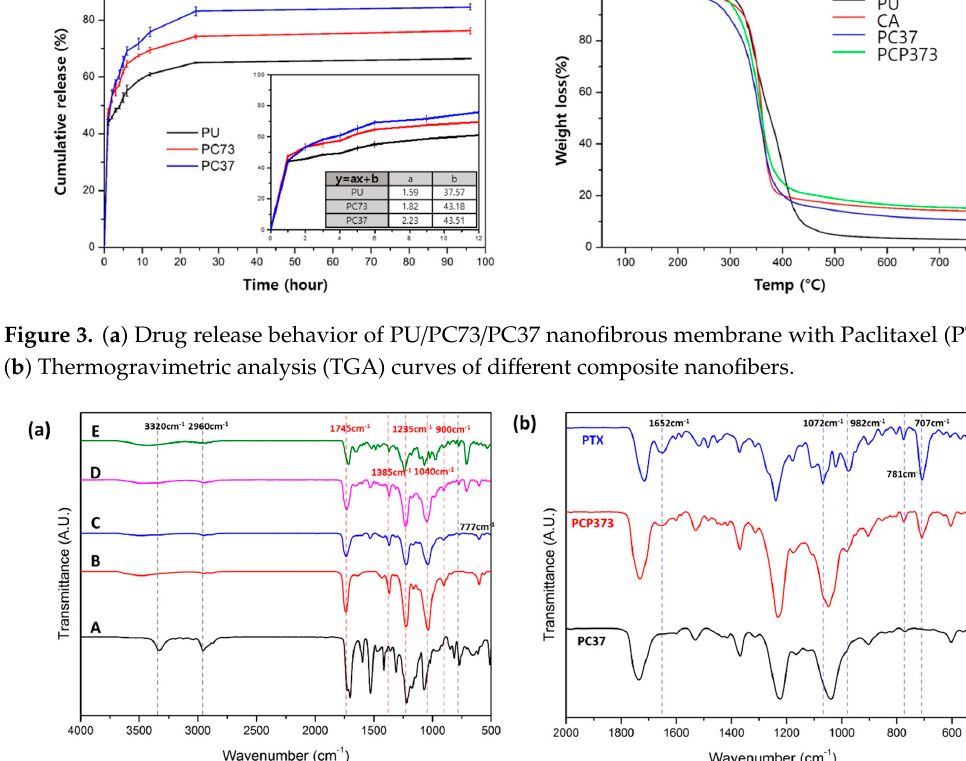
Figure 4. ( a ) FT-IR spectrum of PU(A), PC73(B), PC55(C), PC37(D), CA(E) nanofibrous mats, ( b ) IR spectrum of nanofiber with